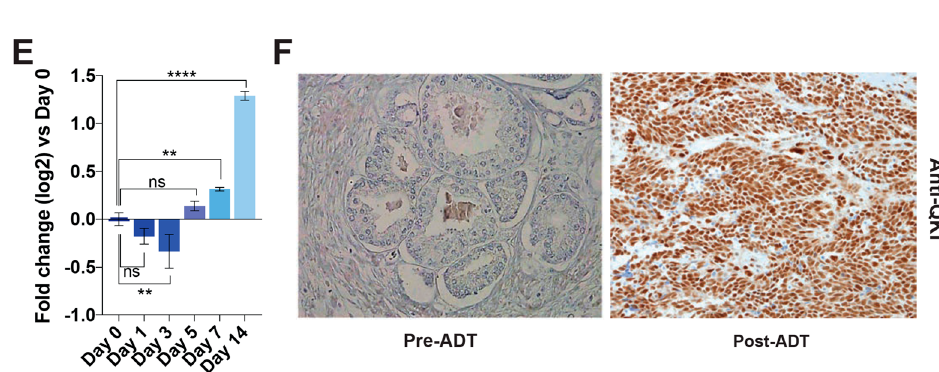
Figure 2. MiR-200 family target QKI is enriched in post-ADT prostate tumors. ( A ) MiR-200 familial target mRNA prediction by TargetScan. Two groups of putative target mRNAs by miR-200b, 200c, 429 and miR-141, 200a were combined, resulting in 218 genes that were overlapped. Their expressional correlation with the miR-200 family score in the WCM CRPC database was then calculated. Using − 0.25 as a cut-off value, the expression of the selected 12 genes was analyzed in prostate cancer cell lines. Genes and cells were clustered to show their distributional relationship. In ( B ) RT-PCR and ( C ) western blot, PC3 overexpresses QKI compared to LNCaP and RWPE1 in. ( D ) QKI mRNA levels after treating the PC3 cell with miR-200 family mimics for 48 h. ( E ) QKI mRNA levels in LNCaP after culturing in charcoal-stripped serum media with 10 uM enzalutamide for 1–14 days. ns = not significant; ** p < 0.01; **** p < 0.001. Student t -test. ( F ) Immunohistochemistry staining of QKI in pre/post-androgen deprivation therapy (six month bicalutamide) exposed prostate tumor tissues (×200).